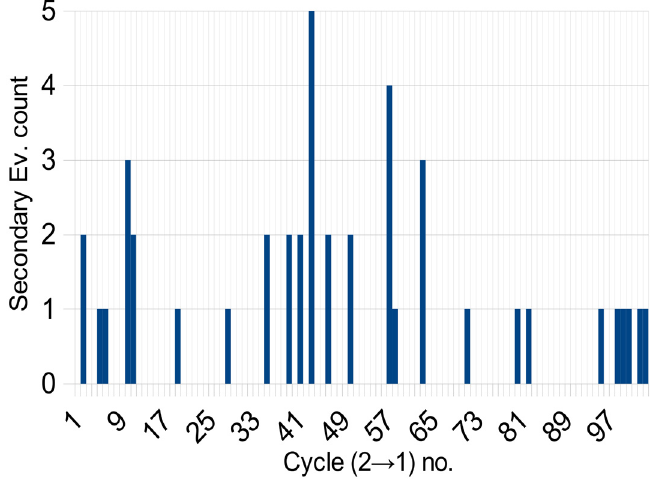
Figure 28. Comparison of the total number of detected impacts among the entire data set.